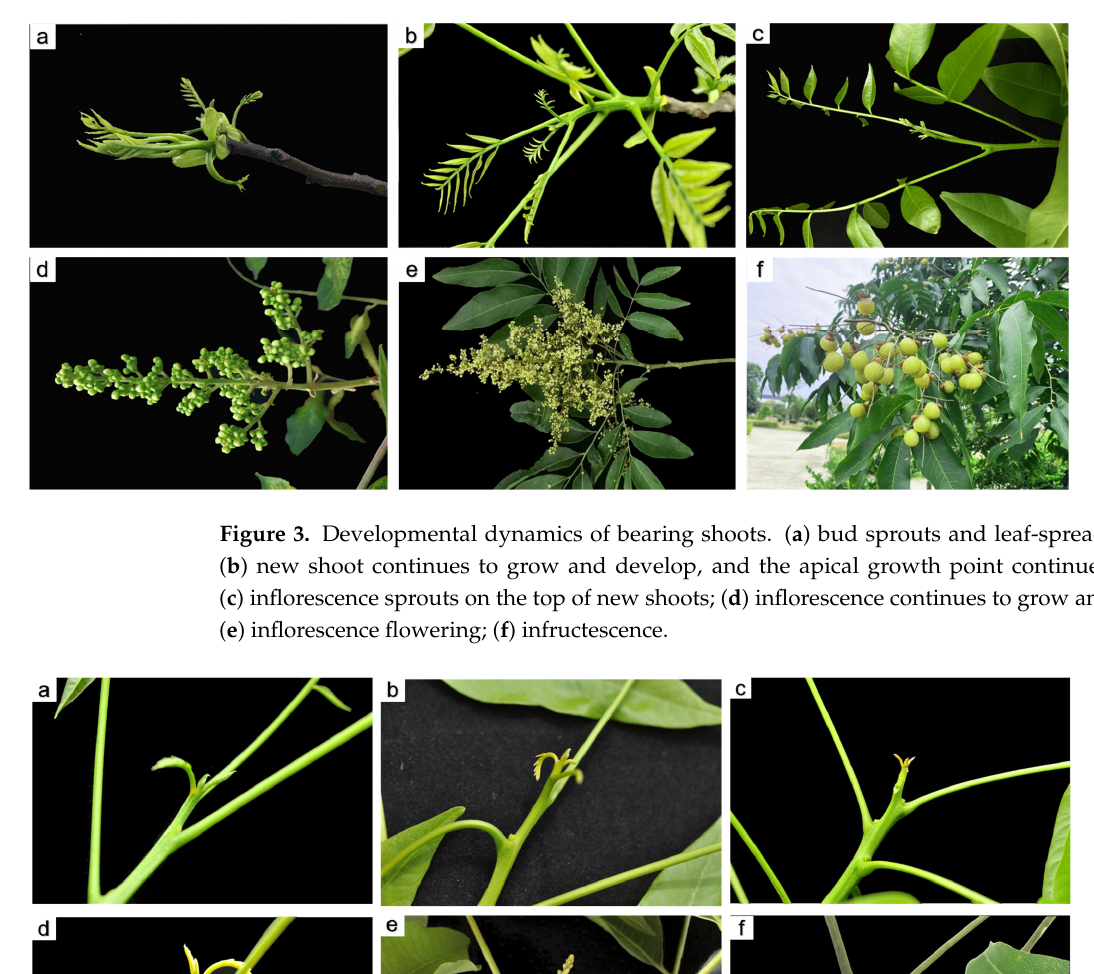
Figure 2. Types of Sapindus mukorossi parent shoots. ( a ) The parent shoots that developed from bear- ing shoots (type F), ( a1 ) persistent infructescence of bearing shoot of previous year; ( b ) the parent shoots that developed from vegetative shoots (type V), ( b1 ) top of vegetative shoot of previous year.